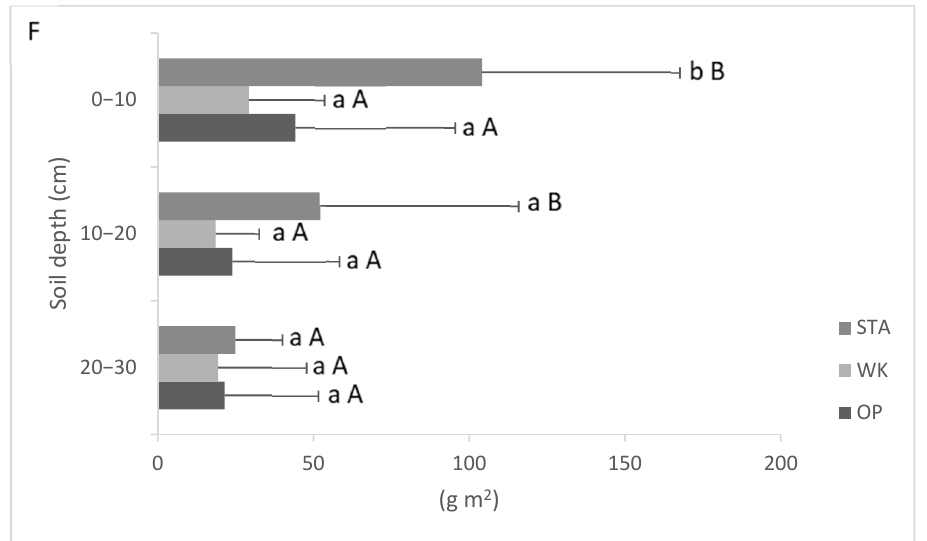
Figure 2. Vertical distribution of fine root morphological traits (( A )—root length, ( B )—surface area, ( C )—root diameter, ( D )—specific root length, ( E )—specific root area, ( F )—fine root biomass) in the analyzed depths of soil profiles in floodplain forests (STA—Starogród, WK—Wielka K ę pa, OP—Ostrów Panie ń ski). Significant differences between the sites at specific depths are marked with different letters, small letters for depths, capital letters for locations ( p < 0.05, Tukey’s test).